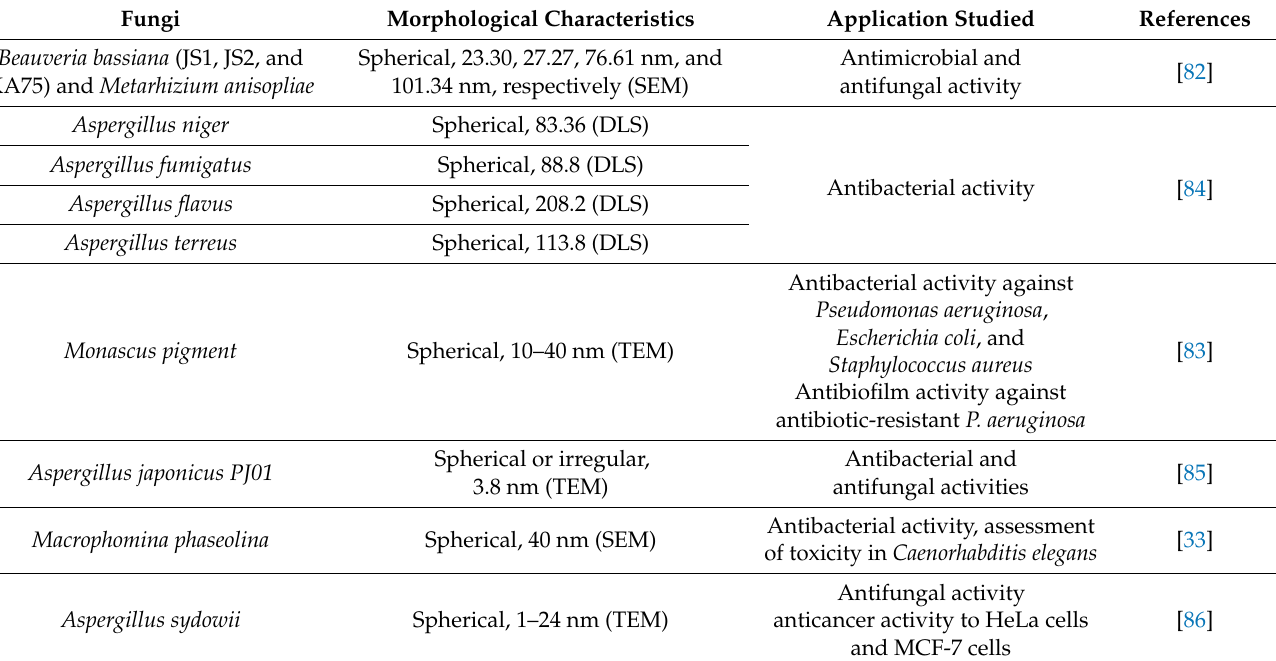
Table 3. Fungi-mediated synthesis of AgNPs, their morphological characteristics, and their